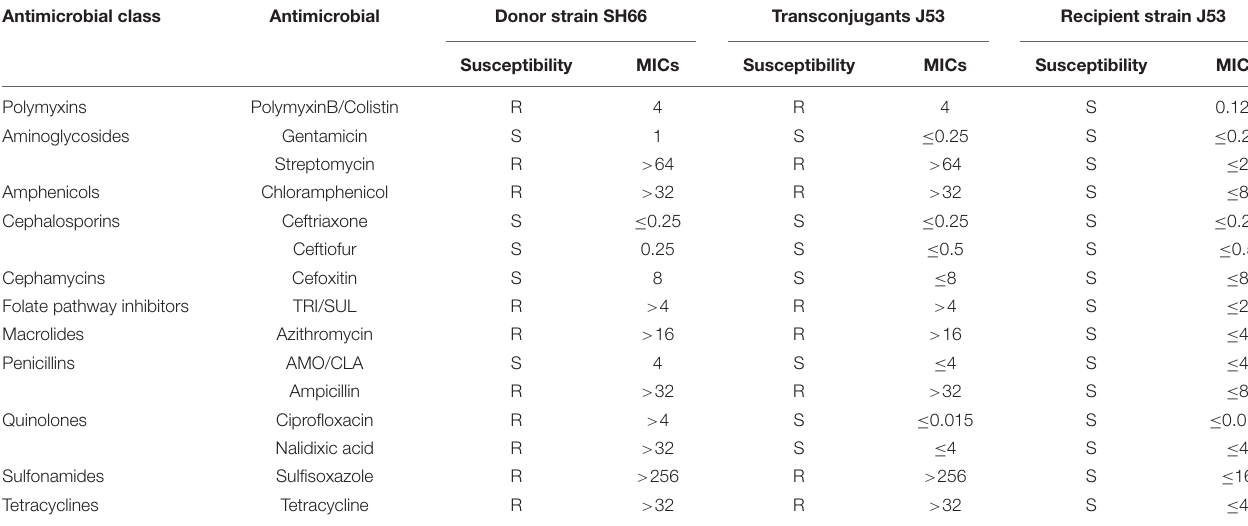
TABLE 2 | Comparisons of antimicrobial resistance levels between the donor E. coli strain SH66, recipient strain J53 and the J53 transconjugants. Antimicrobial